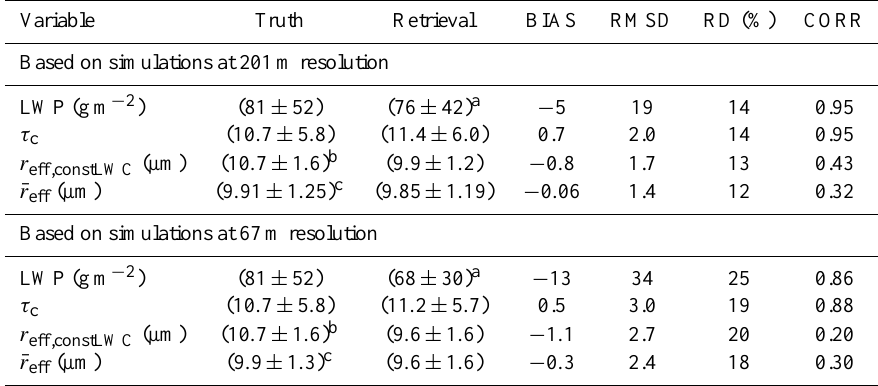
a LWP values are calculated using retrieved τ c and effective radius assuming constant liquid water content in the vertical. b Calculated from the column-integrated LWP and τ c assuming constant liquid water content in the vertical. c Calculated from averaging effective radii over the cloud